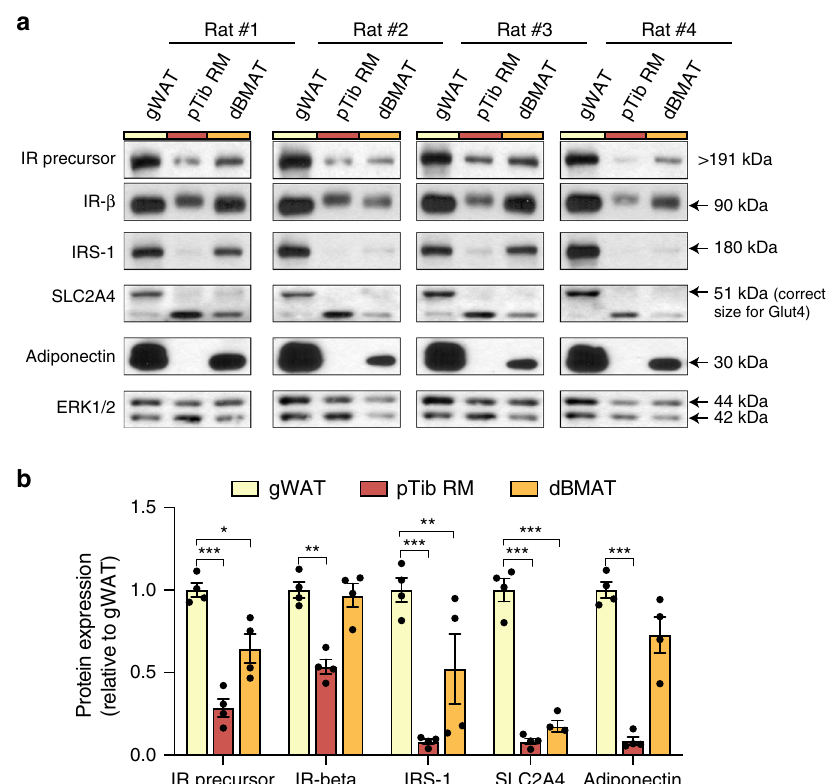
Fig. 2 Expression of proteins essential for insulin signalling is lower in BMAT than in WAT. Total protein was isolated from gWAT, proximal tibial RM (pTib RM) and tibial dBMAT of four rats, as described in the ‘ Methods ’ . a Expression of the indicated proteins was then determined by immunoblotting, with ERK1/2 used as a loading control. b Quanti fi cation of protein expression from ( a ). For each sample, expression of the indicated protein was normalised to ERK1/2 as a loading control. Data are presented relative to expression levels in gWAT as mean ± SEM of four rats. Signi fi cant differences between gWAT and pTib RM or dBMAT were determined by two-way ANOVA and are indicated by * P < 0.05, ** P < 0.01 or *** P < 0.001. Source data and full scans of immunoblots are provided as a Source Data fi